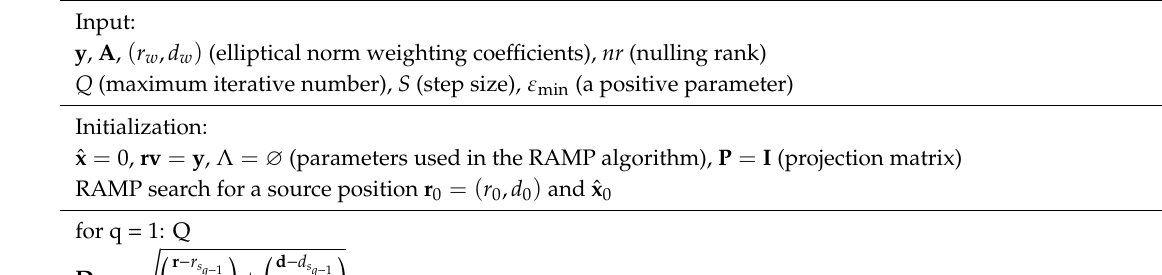
Algorithm 2 RAMP algorithm combined with matrix filter (RAMPMF)